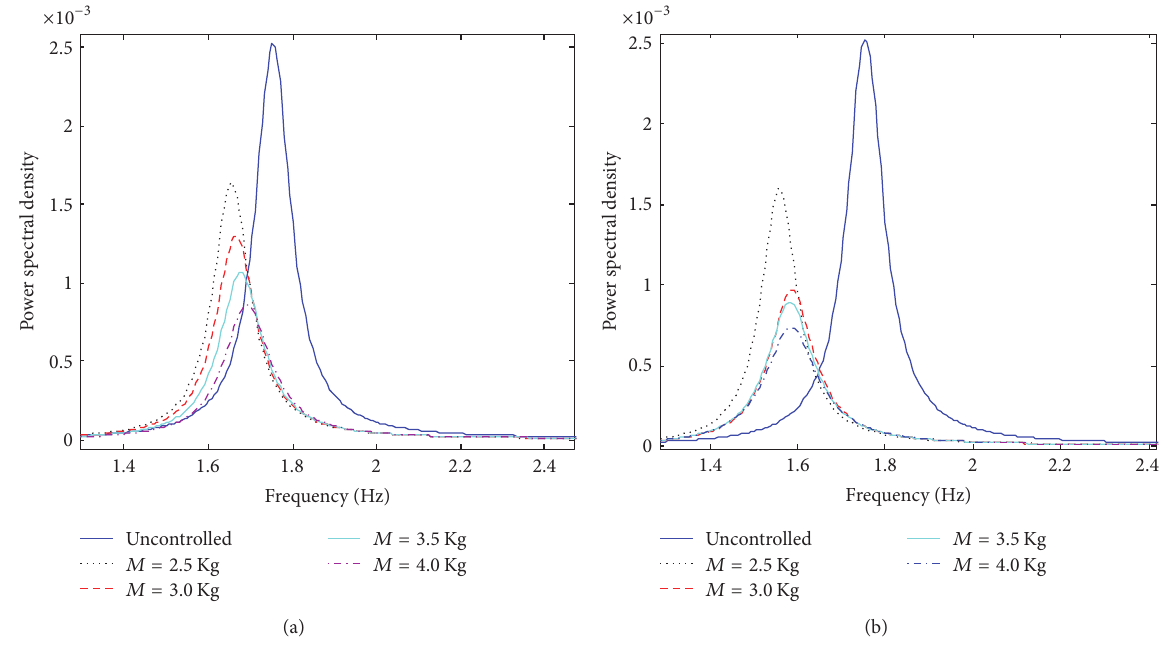
Figure 10: The changes in frequency domain acceleration (g) of controlled and uncontrolled structure versus changes in total mass of passive devices. (a) C-TLD and (b) C-TLCD.